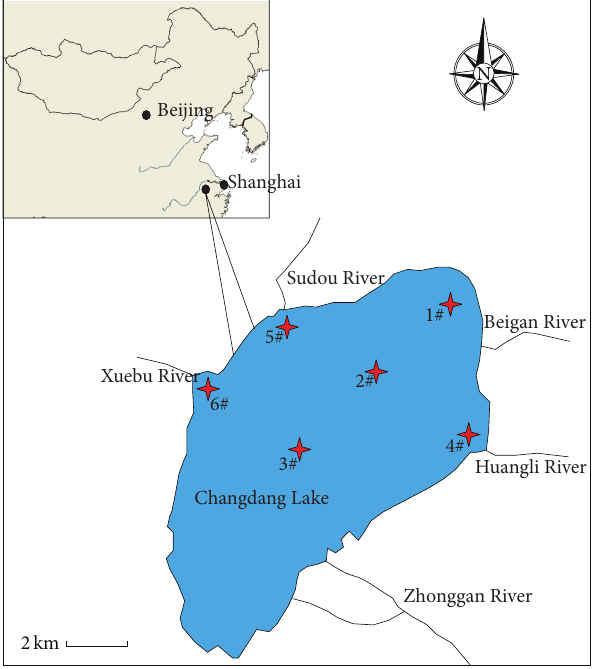
Figure 1: Study area map showing sampling sites in Changdang